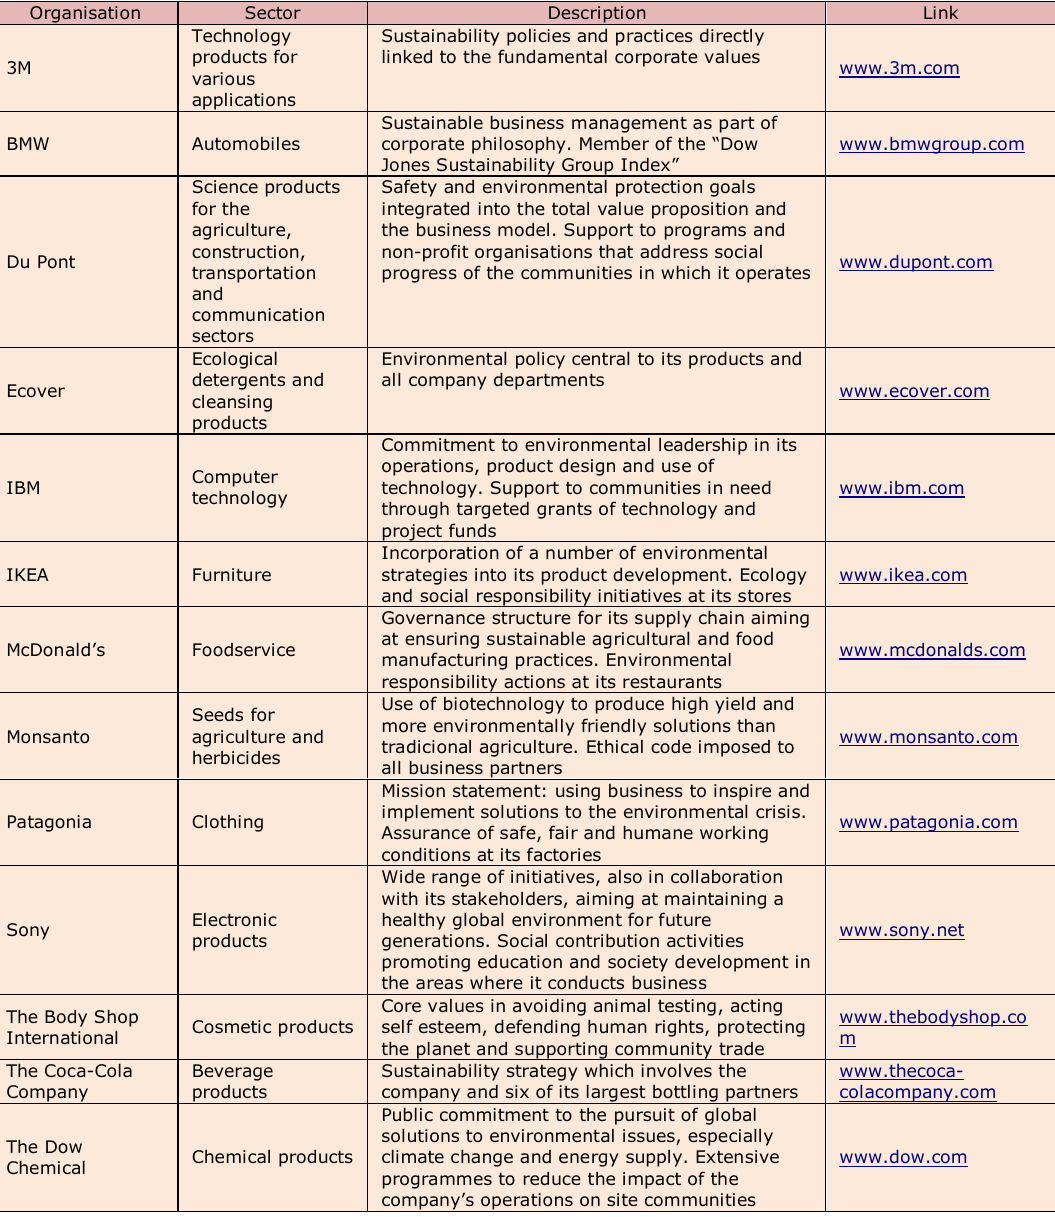
Table 3. Examples of green